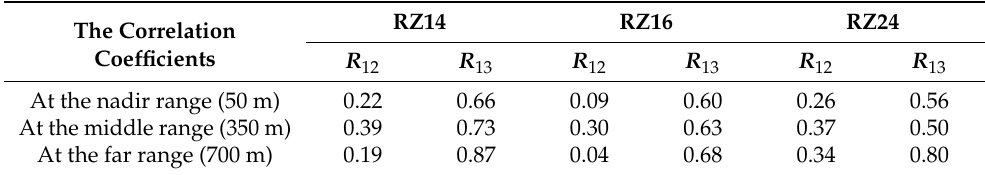
Table 3. The correlation coefficients of the SSE retrieved from IRA images and coupling attitude altimetric